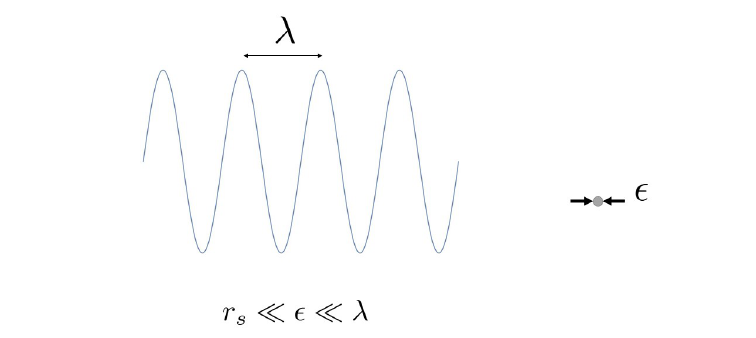
Figure 2 : An EFT regime appropriate for small black holes, for which the UV cutoff scale is much smaller than the length of any low-energy probe, (cid:15) (cid:28) λ , but much larger than the horizon scale (cid:15) (cid:29) r s